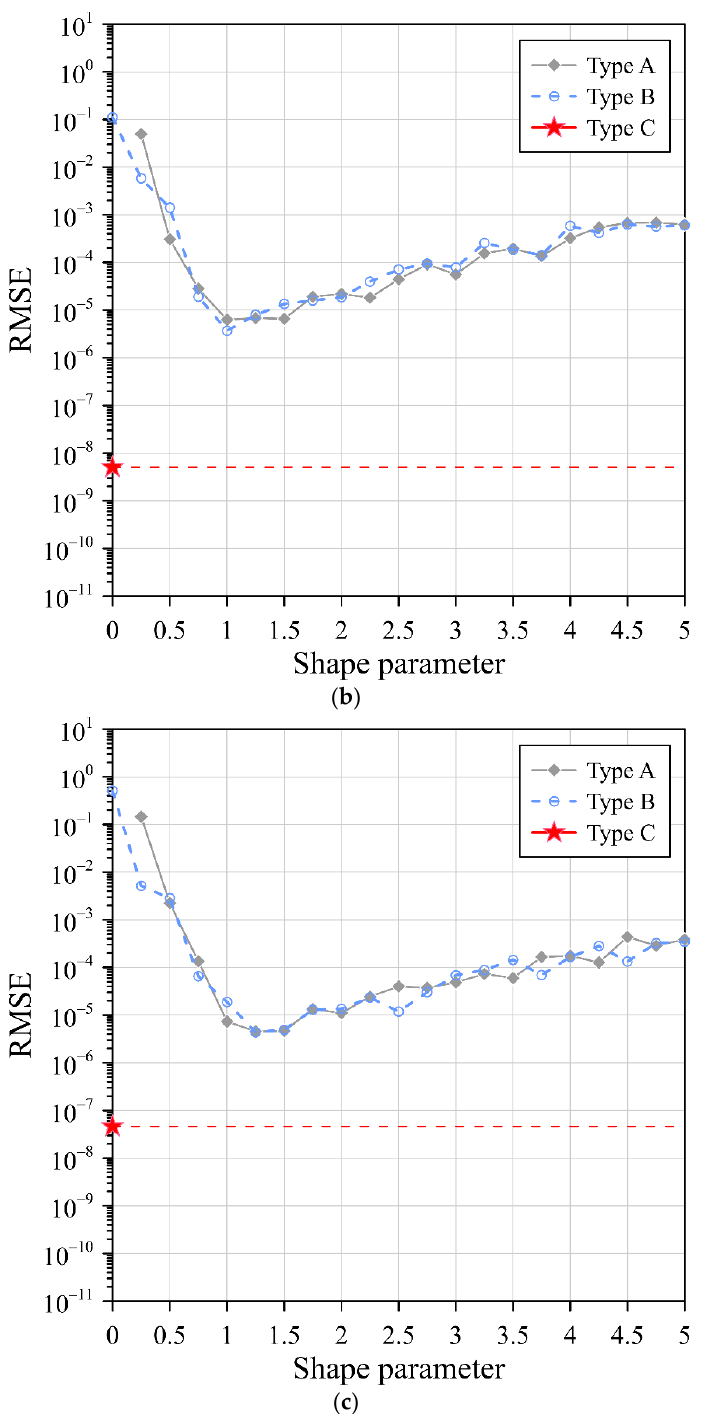
Figure 9. RMSEs of RBFs with three different collocation types: ( a ) Gaussian RBF, ( b ) MQ RBF, and ( c ) IMQ RBF.